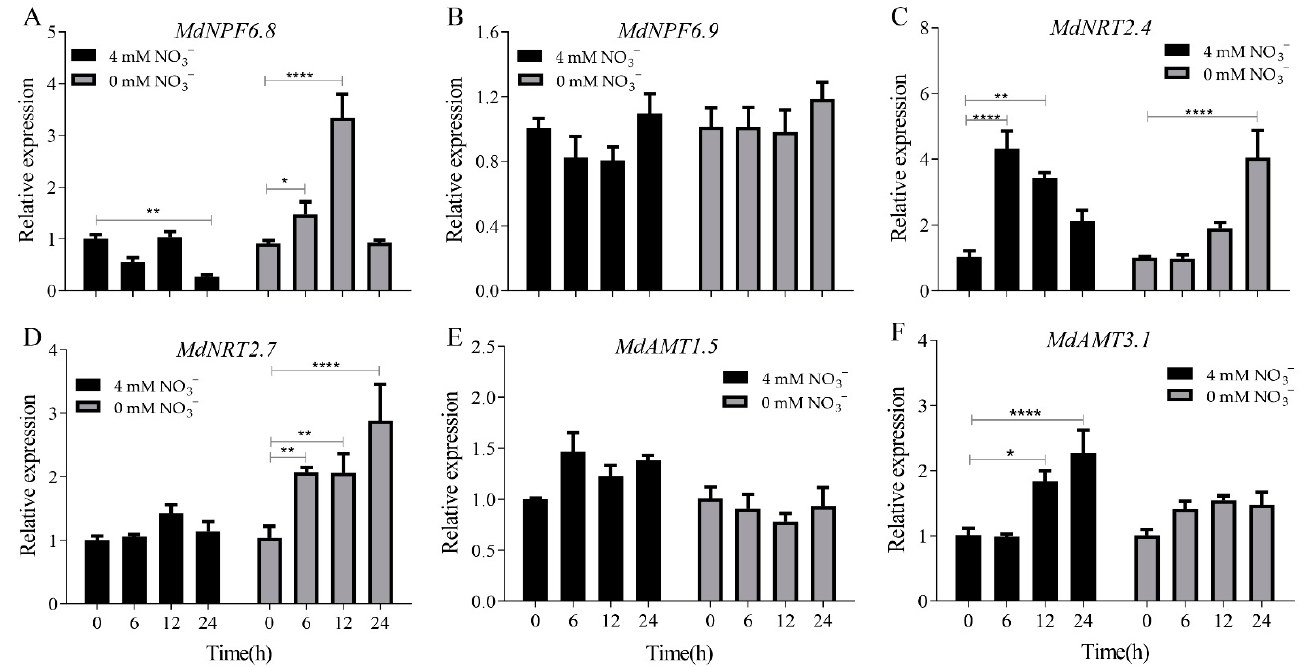
Figure 5. Relative expression of nitrogen transport-related genes in tissue cultured seedlings of ‘Dai- hong’ cultured in mediums with 4 and 0 mM NO 3 − . ( A ). MdNPF6.8 , ( B ). MdNPF 6.9, ( C ). MdNRT2.4 , ( D ) MdNRT2.7 , ( E ) MdAMT1.5, ( F ) MdNMT3.1. The relative level of nitrogen transport-related genes in ‘Dahong’ tissue culture seedlings at 0 h was set to 1. The bars represent means ± SD ( n = 3). Asterisks indicate statistically significant differences (* p < 0.05; ** p < 0.01; **** p < 0.0001).